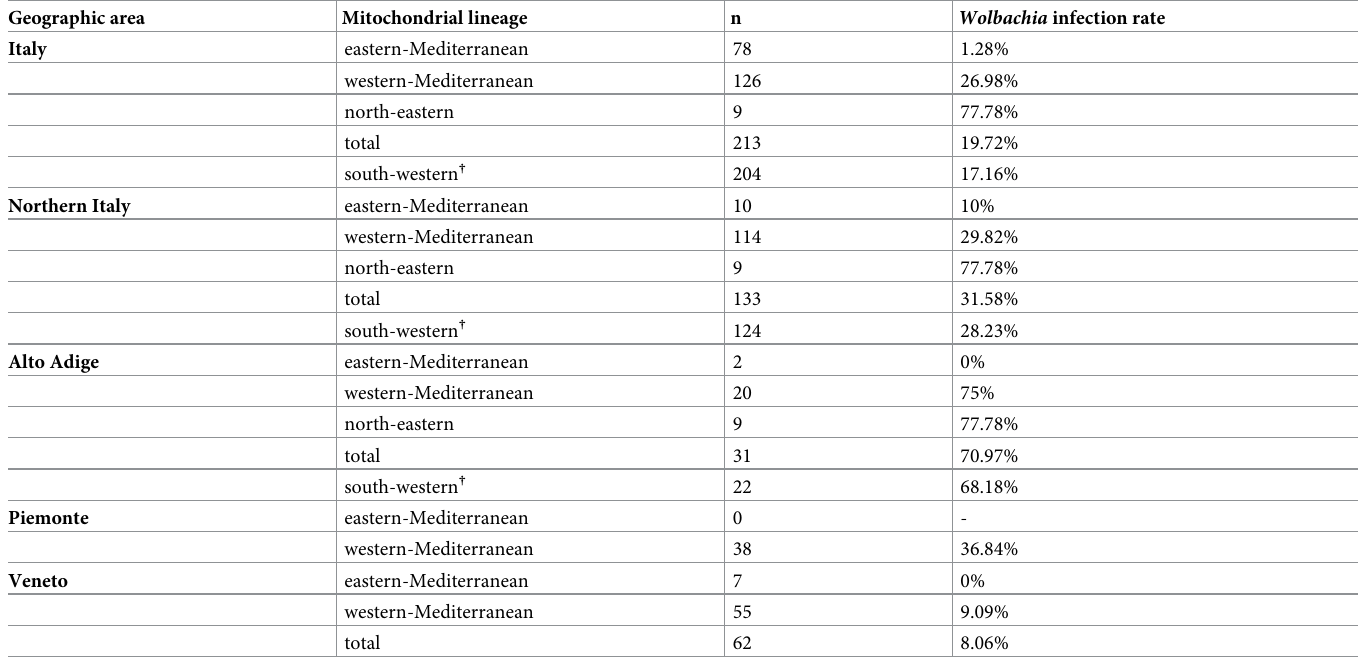
Table 4. Wolbachia infection of mitochondrial lineages of Philaenus spumarius